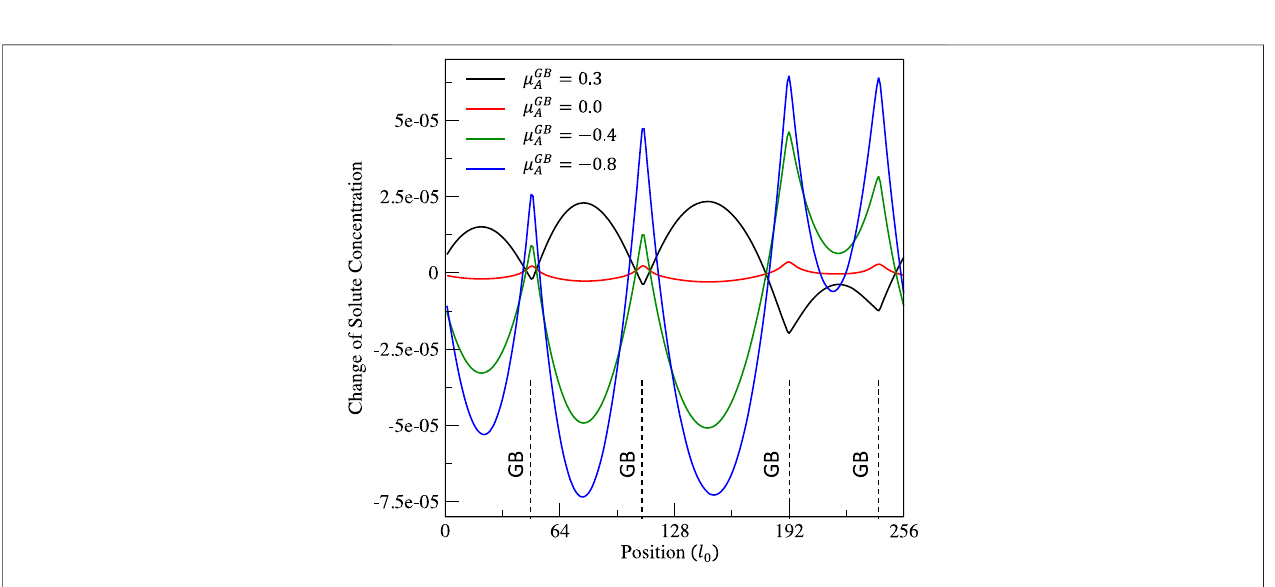
FIGURE 3 | Distribution of solute concentration change Δ c A along the line A 1 A 2 shown Figure 1A for different chemical potential μ GB A .